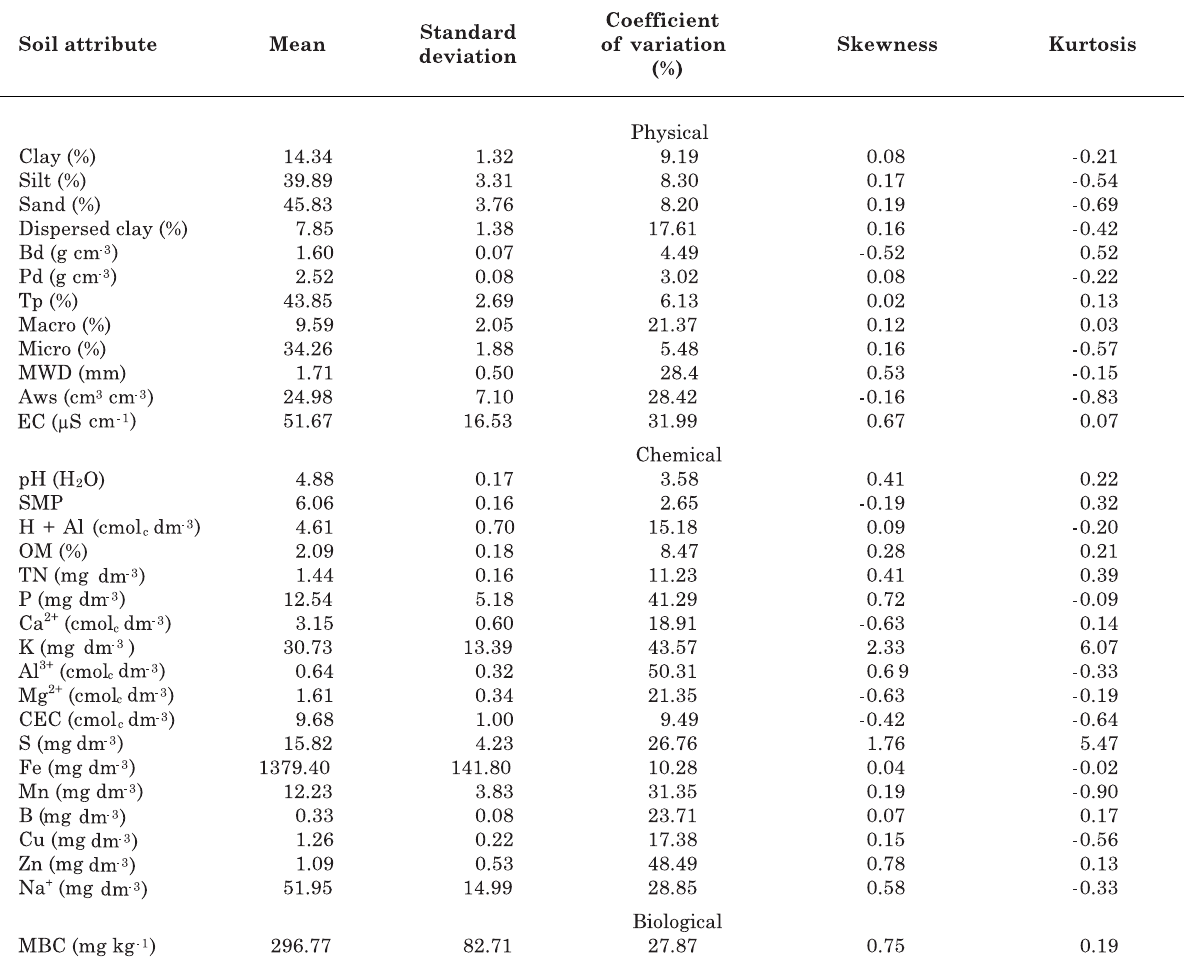
Table 1 . Descriptive statistics of all 31 studied soil properties: mean, standard deviation, coefficient of variation and coefficients of skewness and